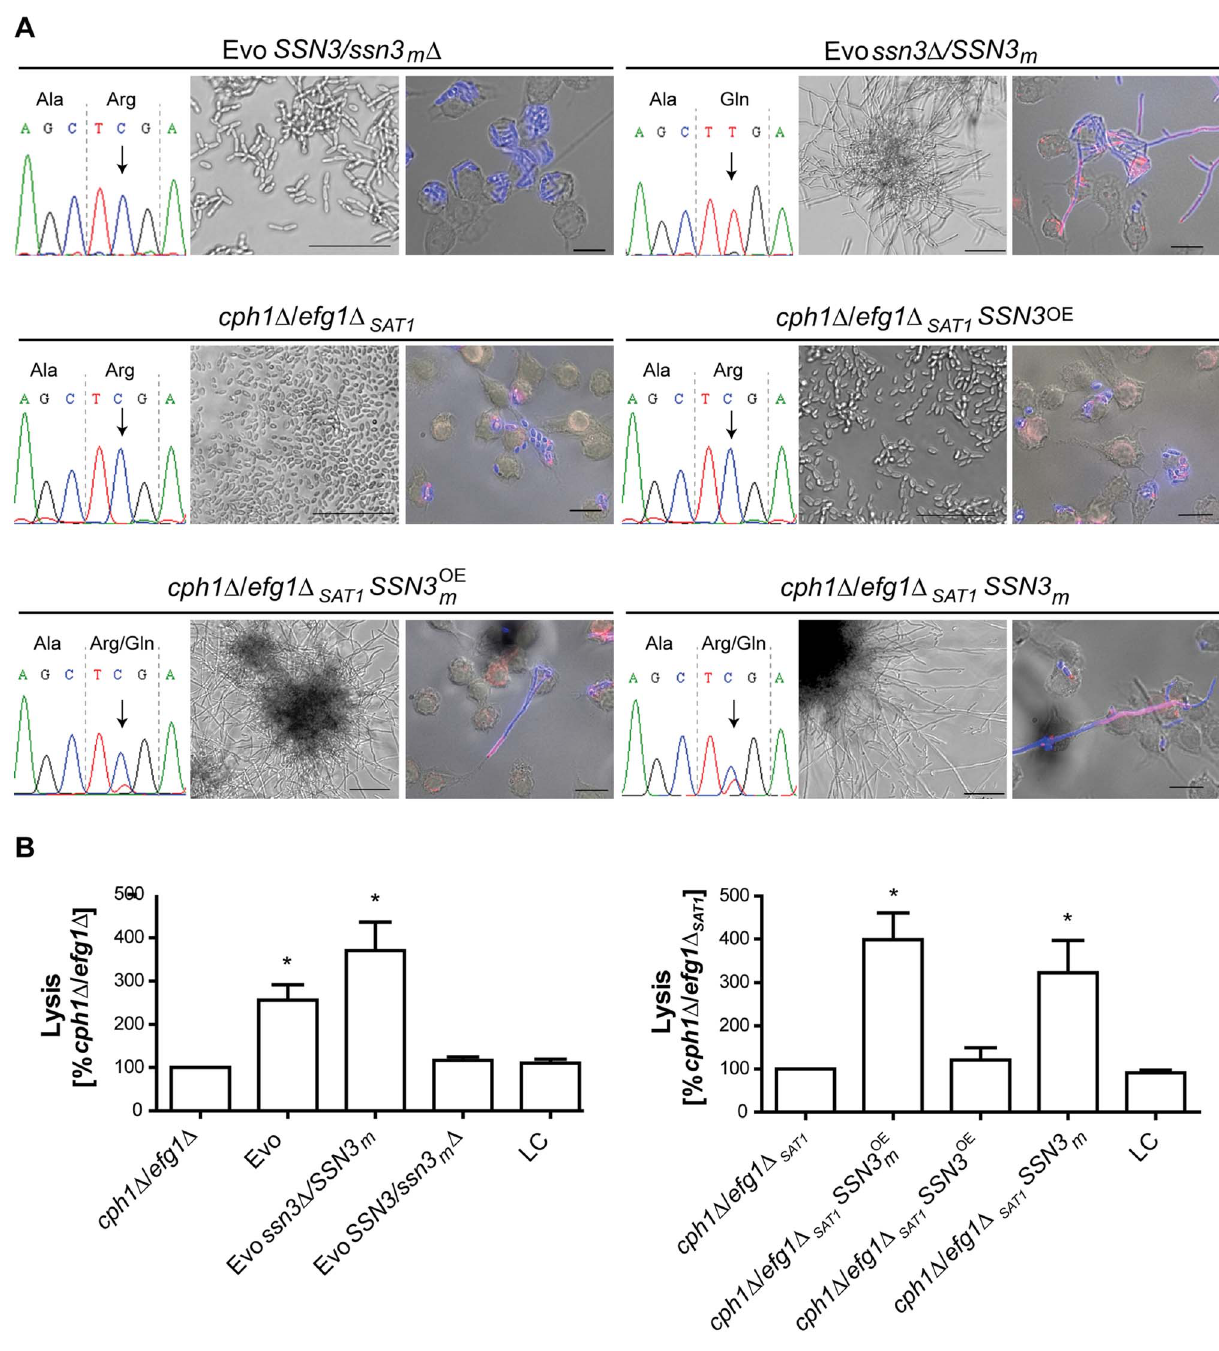
Fig. 7. A single nucleotide polymorphism in SSN3 is essential for filamentation. ( A ) Distinct impact on morphology by: deleting either the mutated ( SSN3 / ssn3 m D ) or the wild type SSN3 allele ( ssn3 D /SSN3 m ) in the Evo strain, by overexpressing either the wild type SSN3 allele ( cph1 D / efg1 D SAT1 SSN3 OE ) or the mutated SSN3 allele ( cph1 D / efg1 D SAT1 SSN3 mOE ) or by expressing the mutated SSN3 allele from its native locus ( cph1 D / efg1 D SAT1 SSN3 m ) in a newly generated cph1 D / efg1 D SAT1 strain. The partial SSN3 sequences demonstrate the homozygosity or heterozygosity of the SSN3 allele (left). Filamentous growth is visible in the Evo ssn3 D / SSN3 m , cph1 D / efg1 D SAT1 SSN3 mOE and cph1 D / efg1 D SAT1 SSN3 m strains after growth for 18 h at 37 u C and 5% CO 2 in DMEM + 10% FBS and during co-incubation with macrophages, but not with the Evo SSN3 / ssn3 m D strain, cph1 D / efg1 D SAT1 and cph1 D / efg1 D SAT1 SSN3 OE strains (scale bars: 18 h, 50 m m and M W , 20 m m; representative pictures are shown) (right). ( B ) Cell damage of macrophages caused by the different strains, as determined by lactate dehydrogenase (LDH) assay after 32 h of co-incubation. Robust host cell damage depends on the presence of the mutated allele SSN3m . Mean and SD of n=4 (*p , 0.05; compared to cph1 D / efg1 D and cph1 D / efg1 D SAT1 respectively; LC=low control, medium only).